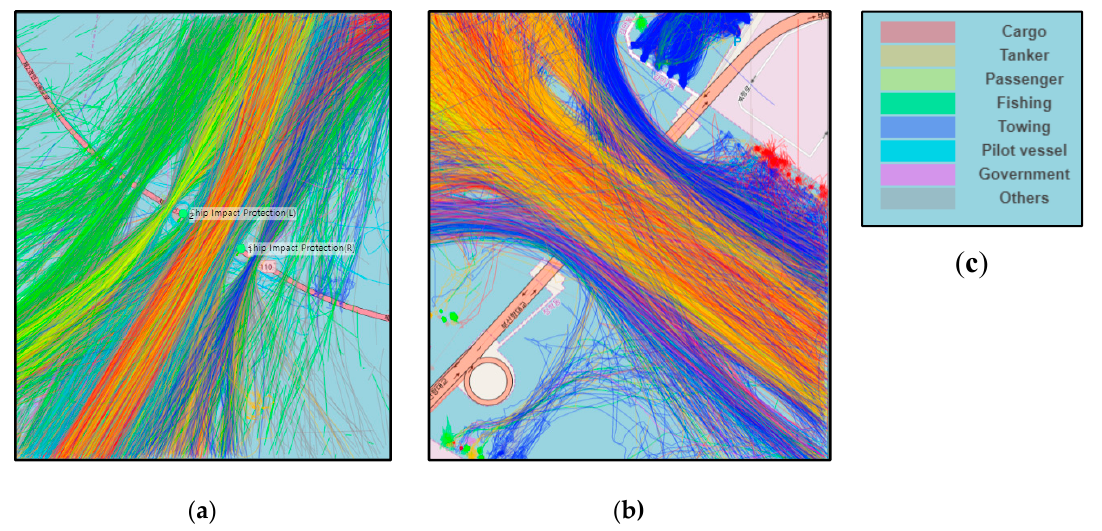
Figure 5. Historical tracks for the ( a ) Incheon bridge, ( b ) Busan harbor bridge and ( c ) legend.